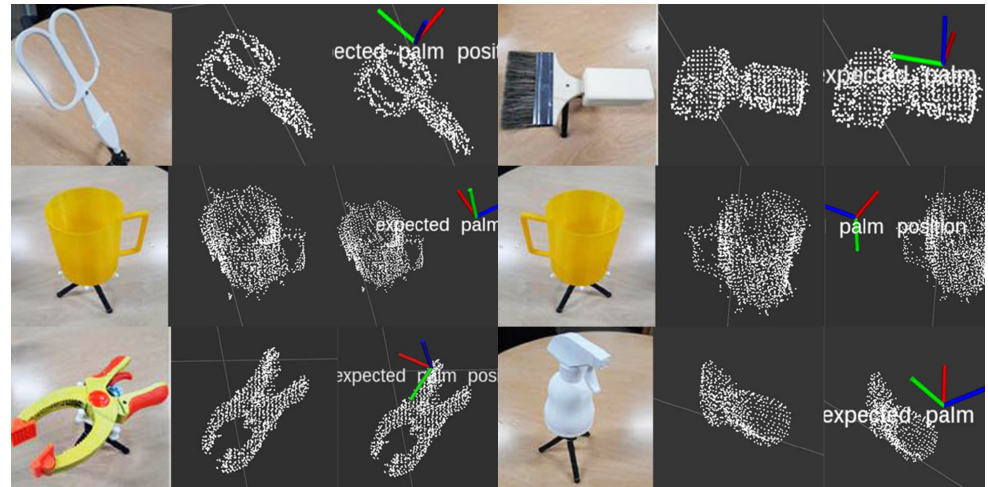
Figure 13. Grasping pose